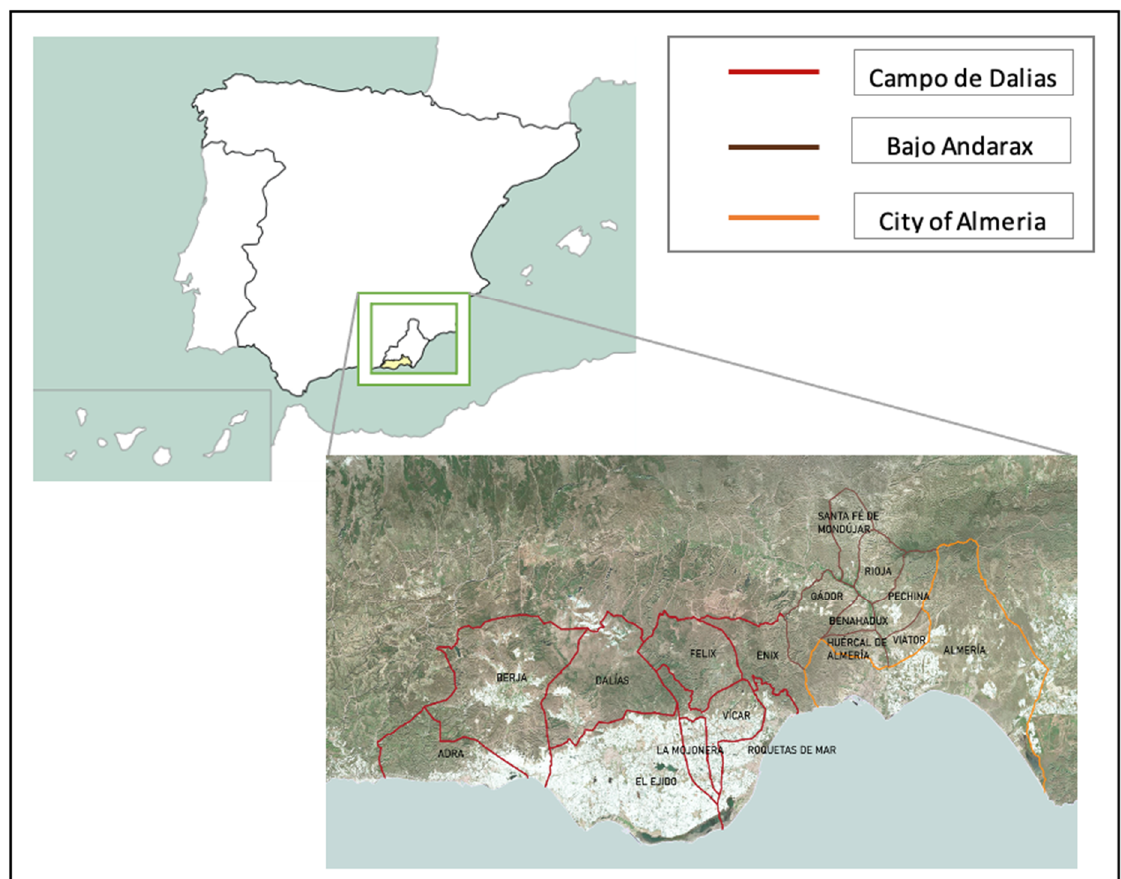
Figure 1. Area of study adapted from Fototeca Digital CNIG. Table 2. Crop distribution in each of the study